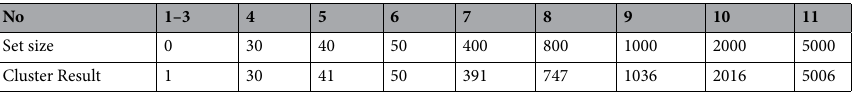
Table 1. Cluster sizes of 2D Gaussian mixture distribution datasets. The resulting clusters 1 through 3 contained one data point each. These data points were distant from the other data points, which are referred to as discrete points. In the BCALoD cluster analysis, such data points are independently grouped into one category. The sizes of cluster 4–6 are 30, 40 and 50, respectively, which are much smaller than the amount of data contained in other clusters; this type of cluster is referred to as a small cluster. The results demonstrate the excellent clustering performance of small clusters by the BCALoD algorithm.